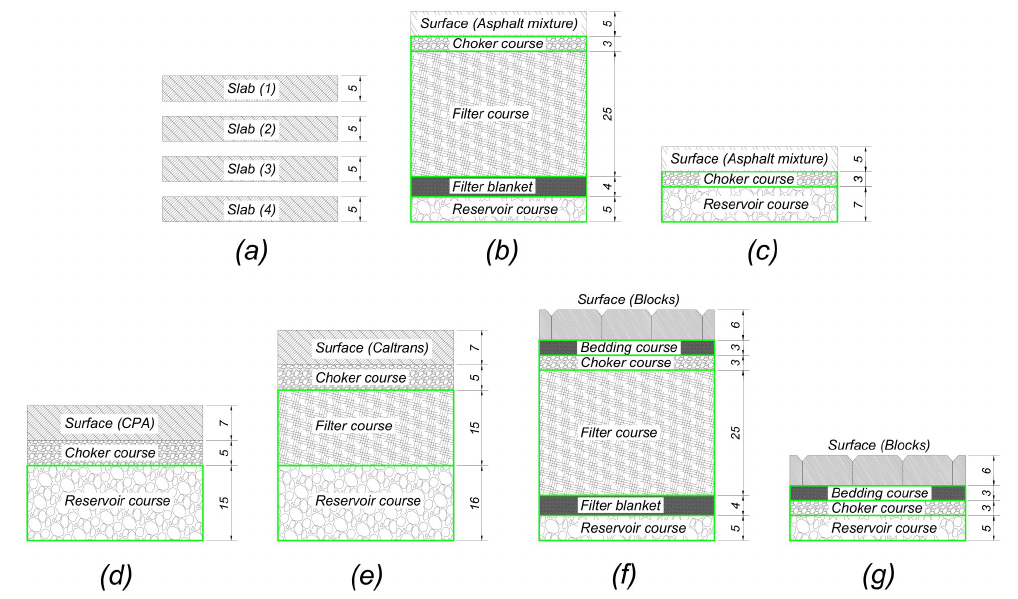
Figure 3. Permeable pavement models analysed in the selected papers. Source: ( a ) permeable asphalt mixtures slabs [45]; ( b ) permeable pavement with filter course [50]; ( c ) permeable pavement without filter course [50]; ( d ) permeable pavement without filter course [53]; ( e ) permeable pavement with filter course [53]; ( f ) permeable pavement with filter course [49]; ( g ) permeable pavement without filter course [49]. The figure is based on materials and thicknesses of papers [45,49,50,53]. The green line represents the geotextile use. All dimensions are in